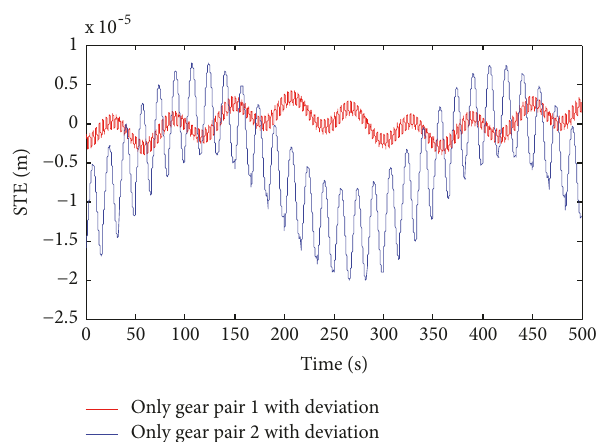
Figure 7: Effects comparison of two gear pairs on TE.